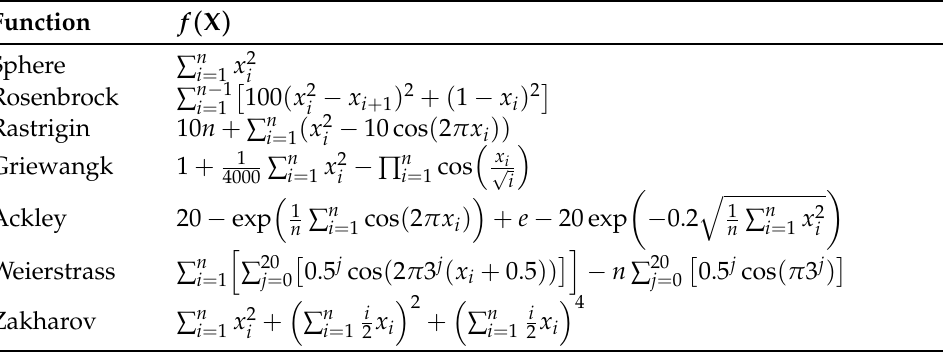
Table 2. Definition of the benchmark functions.